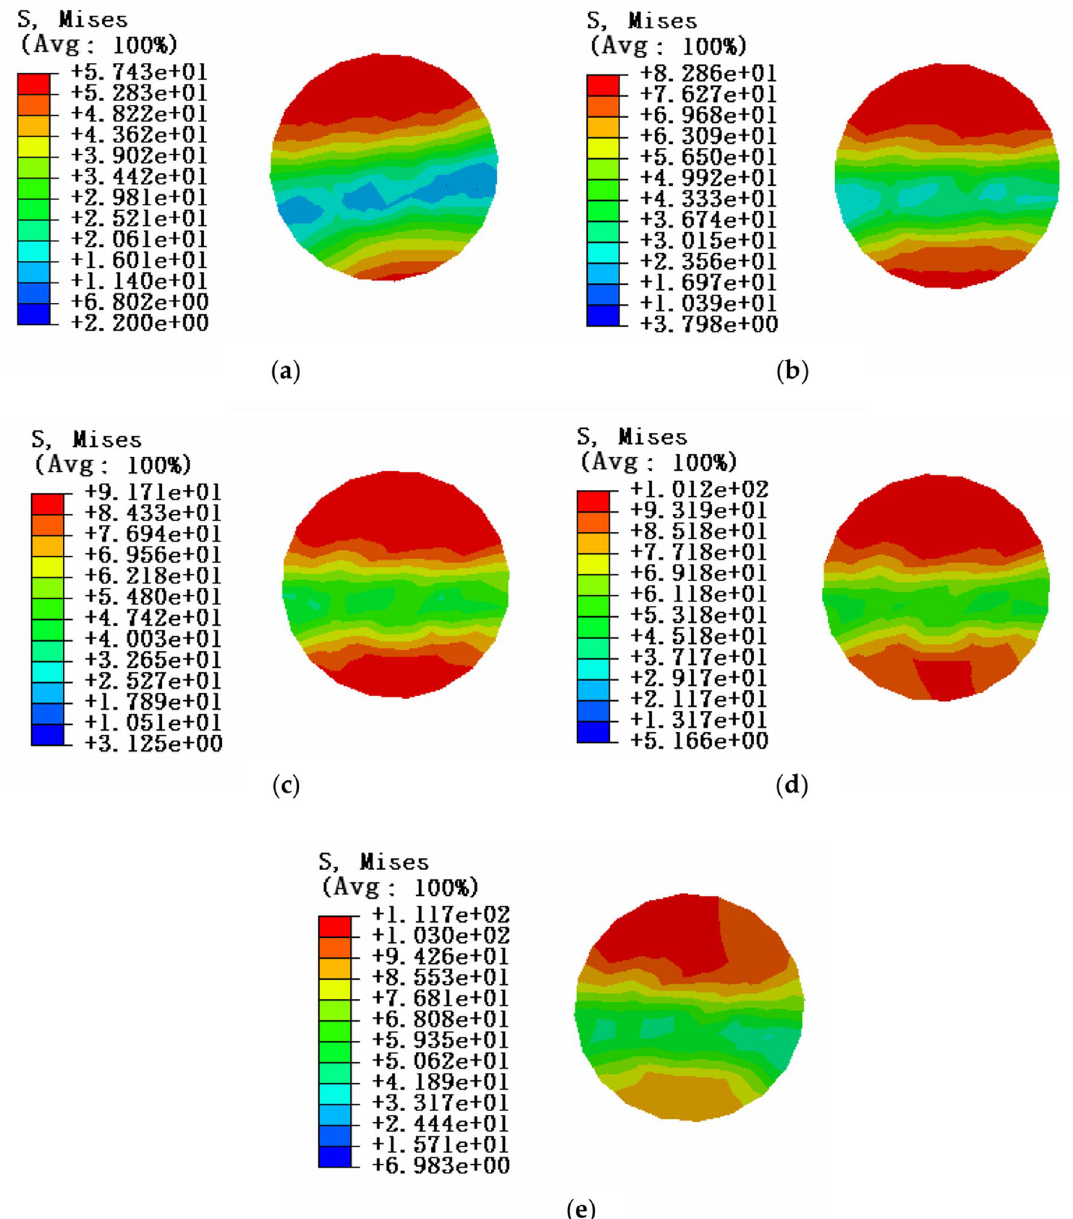
Figure 19. Equivalent stress cloud diagram of midpoint position of aluminum strand at tension load of 10kN ( a) Equivalent stress cloud diagram of aluminum strand at an envelope angle of 3°; ( b ) Equivalent stress cloud diagram at an envelope angle of 6°; ( c ) Equivalent stress cloud diagram at an envelope angle of 9°; ( d ) Equivalent stress cloud diagram of aluminum strand at an envelope angle of 12°; ( e ) Equivalent stress cloud diagram of aluminum strand at an envelope angle of 15°.